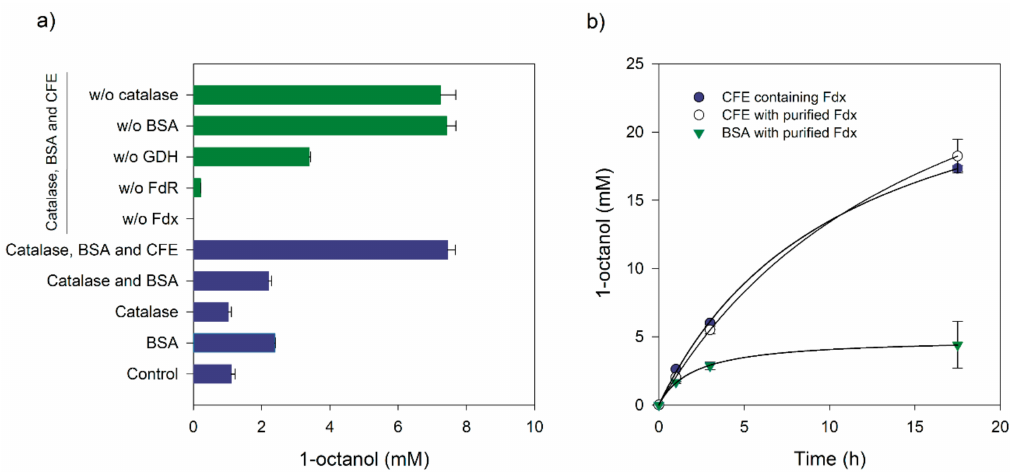
Figure 2. Effect of Bovine serum albumin (BSA), catalase and cell-free extract (CFE), or the combination thereof, on 1-octanol production from n -octane by CYP153A6 ( a ) Blue bars represent the effect of additives. Green bars represent all additives without ( w / o ) one component. Reaction conditions: 1 mL aqueous reaction mixture containing 1 µ M CYP153A6, 1 µ M FdR, 6 µ M Fdx, 0/10 mg mL − 1 BSA, 0/0.5 U mL − 1 catalase, 0.1 mM NADH, 0/0.2 U mL − 1 GDH, 200 mM glucose, 0/30% ( v / v ) CFE from 200 g (wet weight) L − 1 cell suspension, buffer: 200 mM Tris-HCl (pH 8) with 250 µ L n -octane